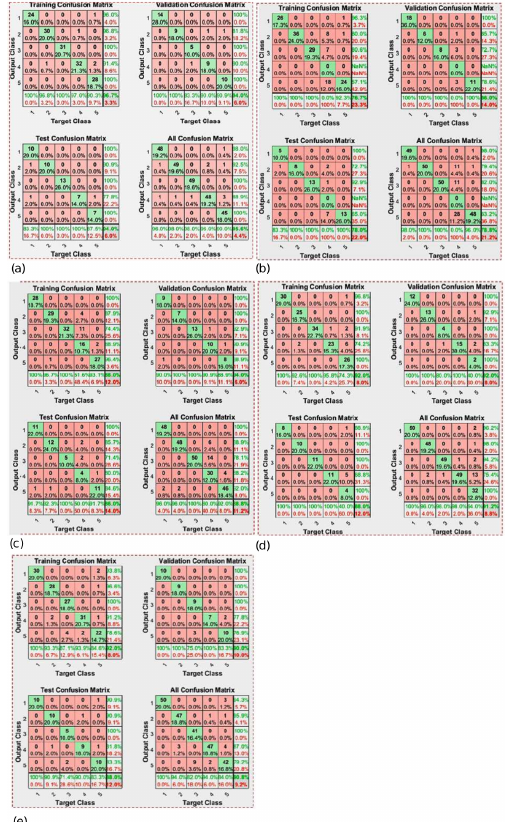
Figure 19. Evaluated TF’s confusion matrix. ( a ) Trainlm, ( b ) Trainbfg , ( c ) Traingcp, ( d ) Trainoss and ( e )